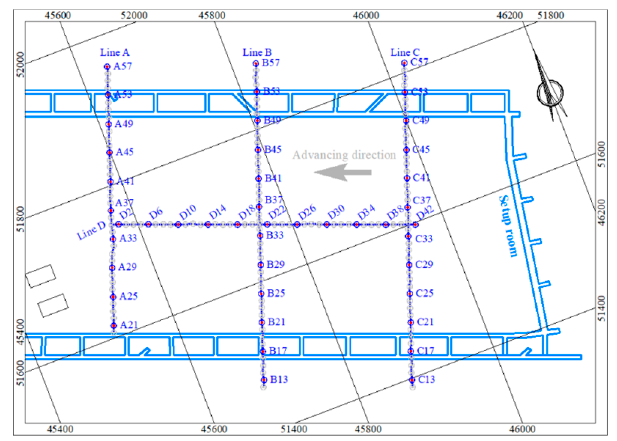
Figure 7. Plane position diagram of MT detection lines and working face.